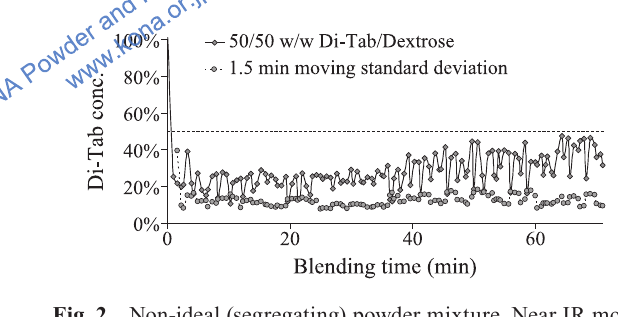
Fig. 2 Non-ideal (segregating) powder mixture. Near IR mon- itoring of the composition of a 50:50 dextrose-Di-Tab mixture as a function of blending time. Reprinted with permission from Ref. (Ely D. et al., 2006). Copyright: (2006) Elsevier